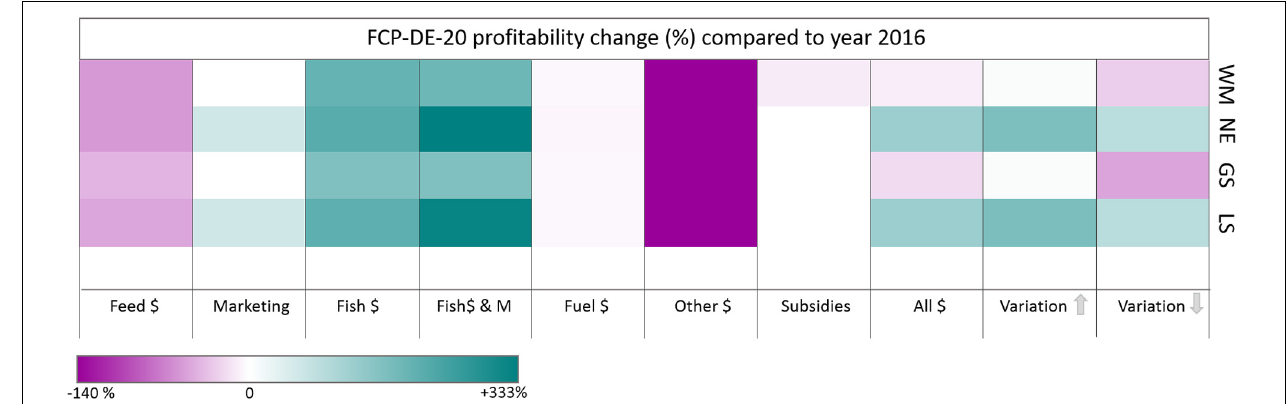
FIGURE 9 | Separate effects of different factors on profitability (market returns against cash costs without interests) of a best practice German carp farm under the four scenarios World Markets (WM), National Enterprise (NE), Global Sustainability (GS) and Local Stewardship (LS). $ = price, M = Marketing referring to region marketing options under Protected Geographic Indications label. Upper and lower variation refers to 95% upper and lower probability ranges from Monte Carlo simulations of future price